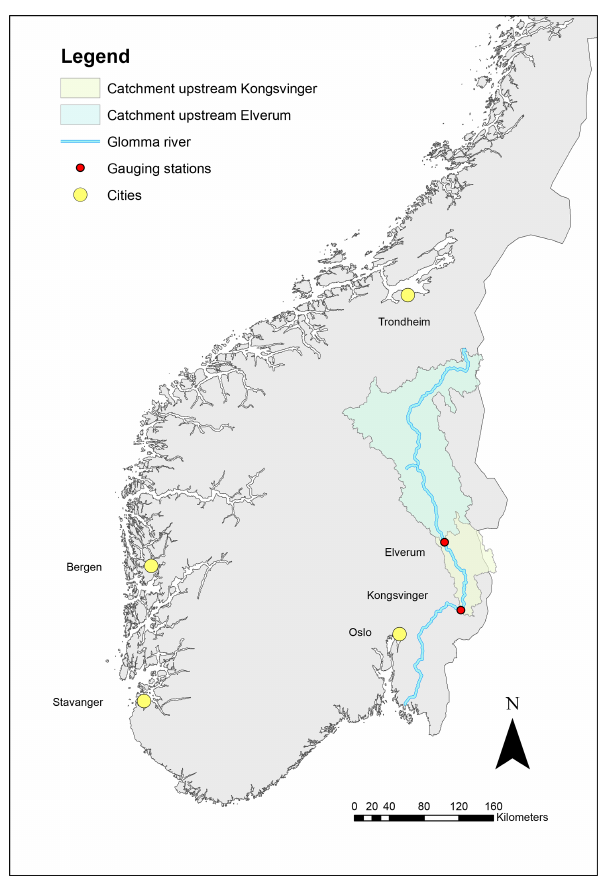
Figure 1. The location of the streamflow gauging station at Elverum used for flood frequency analysis and the site for paleodata collec- tion close to